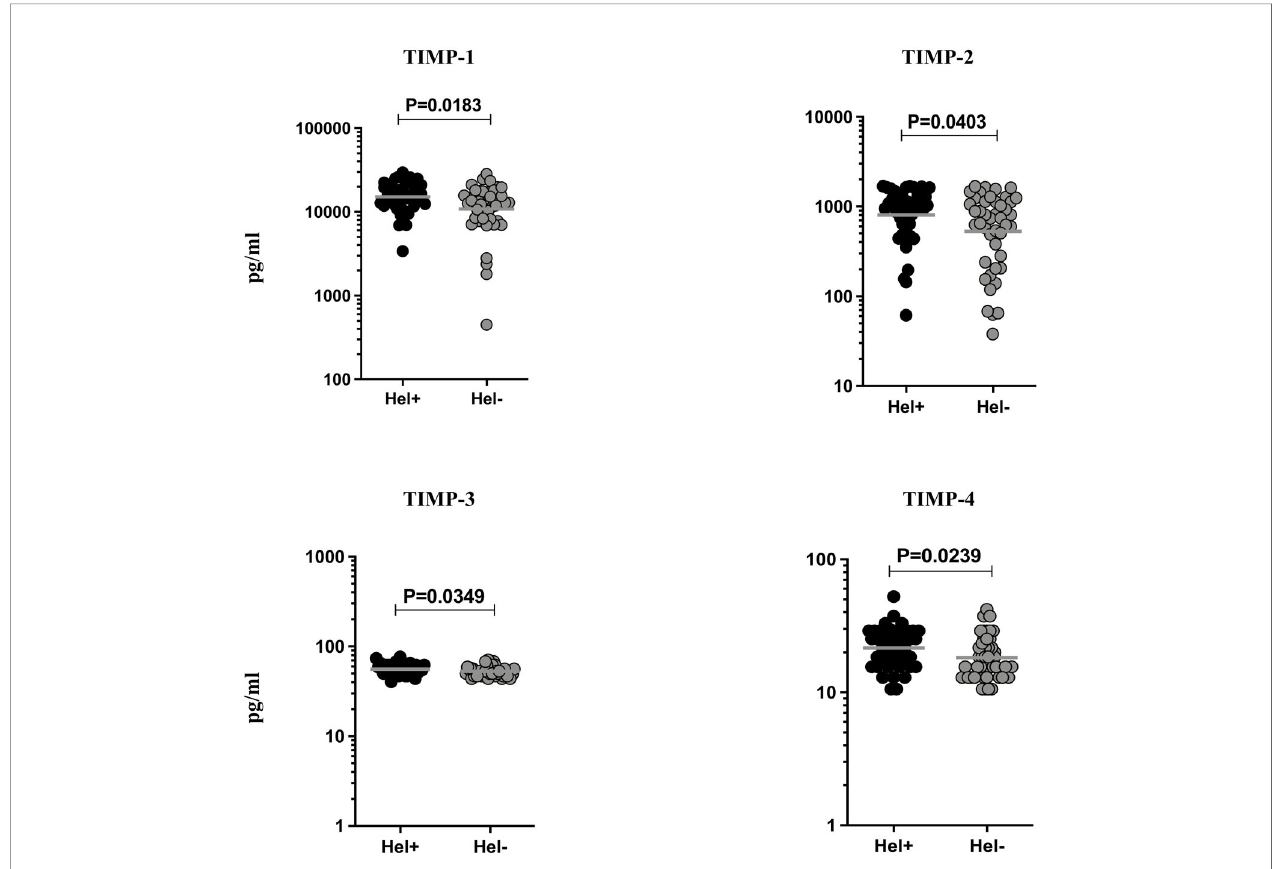
FIGURE 2 | Circulating levels of tissue inhibitors of metalloproteinases (TIMPs) were elevated in TBL-Hel+ coinfected individuals. The systemic levels of TIMPs (1, 2, 3, 4) were examined in TBL-Hel+ (n = 44) and TBL-Hel- (n = 44) individuals. The results are given as scatter plots with each circle indicating a single individual and the bar representing the geometric mean. P values were calculated using Mann-Whitney U